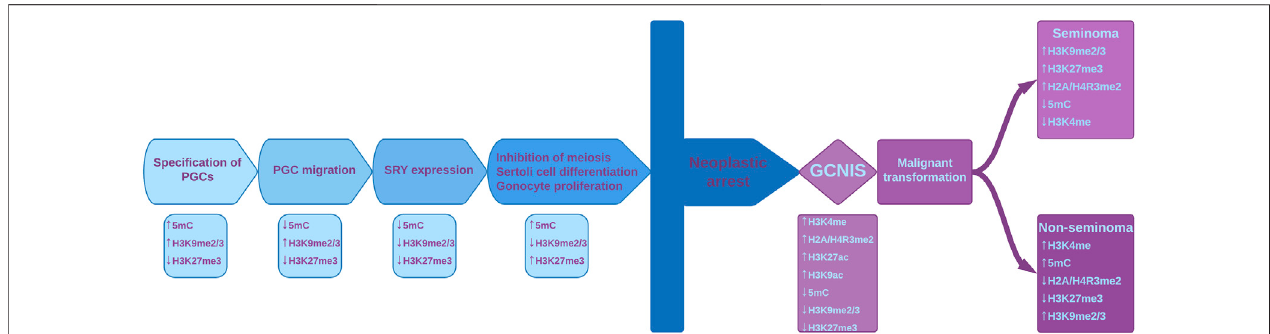
FIGURE 2 | Epigenetic reprogramming in male gamete lineage and the epigenetic disturbances during malignant transformation. The main events that take place during normal development are shown, with their speci fi c epigenetic modi fi cations depicted under each event. Chromatin modifying enzymes play important regulatory roles during fetal gonadal development by regulating histone marks and DNA methylation. Histone marks and 5meC are important regulatory set points during normal fetal gonadal development but also in the neoplastic transformation in pathogenesis of TGCT. Due to various factors, neoplastic arrest can occur and normal developmentisthushalted.ThisleadstoGCNISwhichisassociatedwithdisturbancesofepigeneticmodi fi cations.GCNIShasESC-likefeatures,includingthepresence of bivalent markers. At some point, seminomatous or non-seminomatous tumors can develop, with their listed speci fi c modi fi cations. PGCs – primordial germ cells; SRY – sex determining region Y protein; GCNIS - germ cell neoplasia in situ ; ESC – Embryonic stem cell.